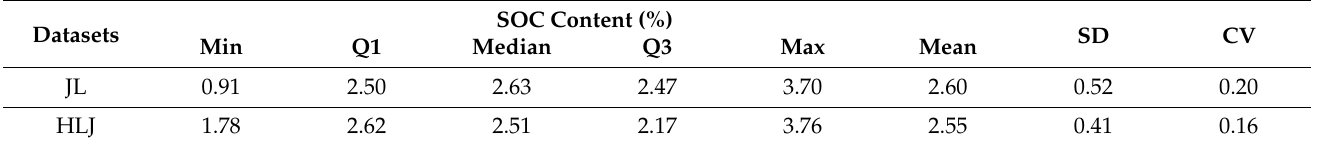
Table 1. Soil datasets for this research.